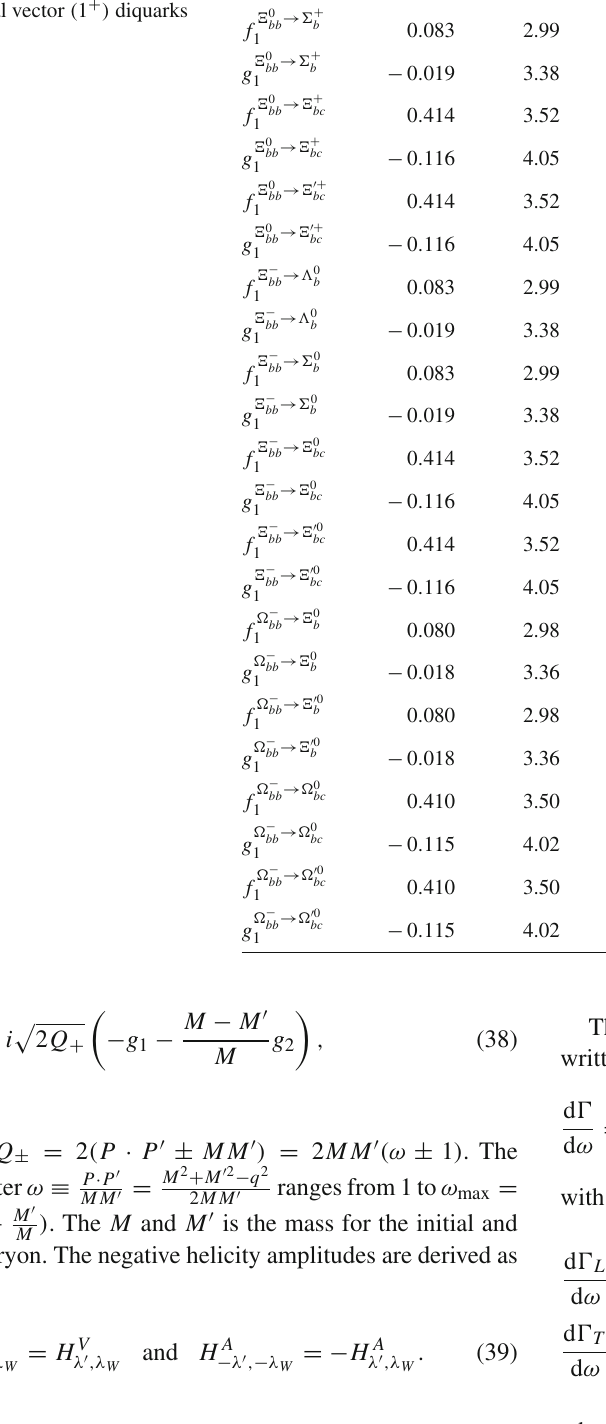
Table 11 Same as Table 9 but for the doubly bottom baryons with axial vector ( 1 + )